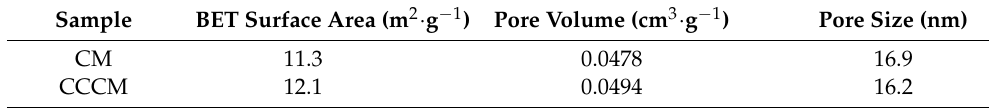
Table 3. The BET surface area, pore size, and pore volume of CM and CCCM. Sample